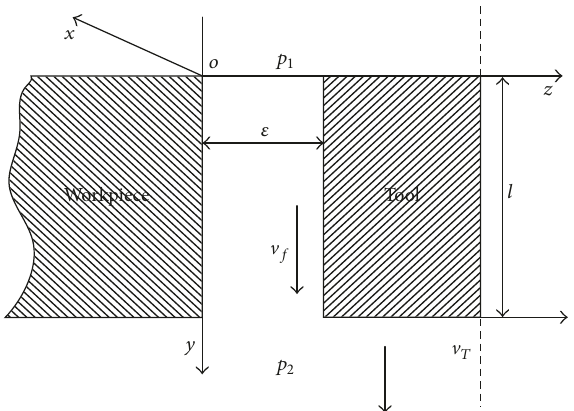
Figure 2: Schematics of interelectrode